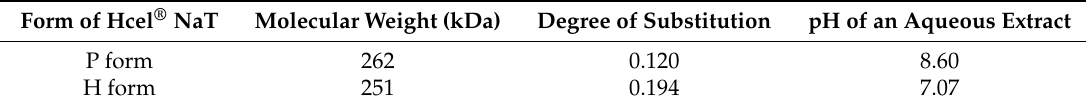
Table 2. Chemical characterization of the P and H forms of Hcel ®